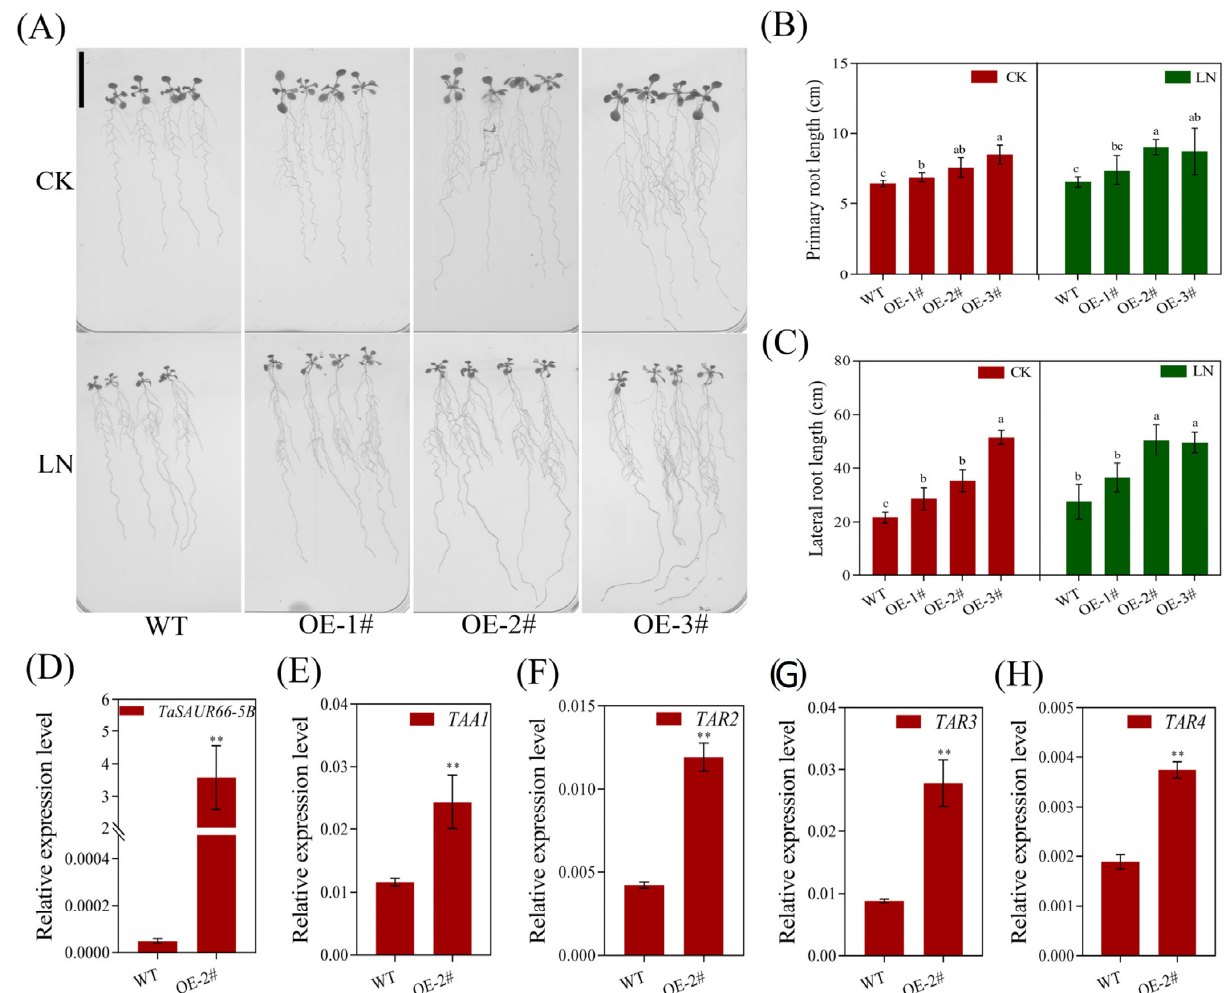
Figure 5. Overexpression of TaSAUR66-5B in Arabidopsis thaliana up-regulates key genes in auxin biosynthesis and promotes root growth. ( A ) Root phenotypes of Arabidopsis transgenic lines under normal nitrogen (CK) and low nitrogen (LN) conditions. Bar = 2 cm. ( B ) The primary root length of Arabidopsis wild-type (WT) and transgenic lines. ( C ) The lateral root length of WT and transgenic lines. ( D – H ) The relative expression levels of key genes in auxin biosynthesis TAA1, TAR2, TAR3 , and TAR4 in WT and transgenic line. The relative expression levels were normalized to the expression of AtActin by 2 −(cid:52) Ct . ** indicates significant difference ( p < 0.01). Different lower case letters above columns indicate statistical differences at p < 0.05